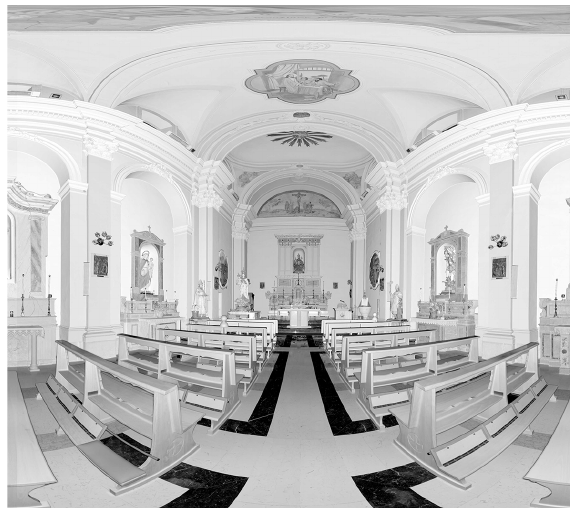
Figure 3. The late church of S. Pietro in Vincoli.